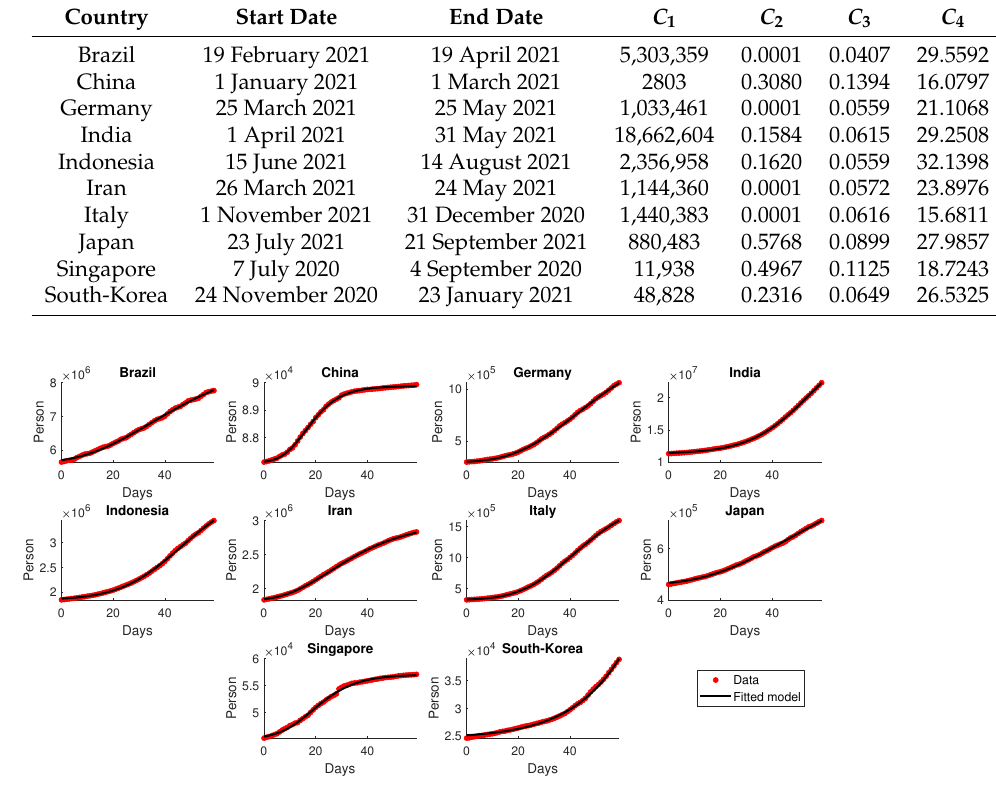
Figure 8. Fitting results ¯ K of cumulative data for the second wave transmission.